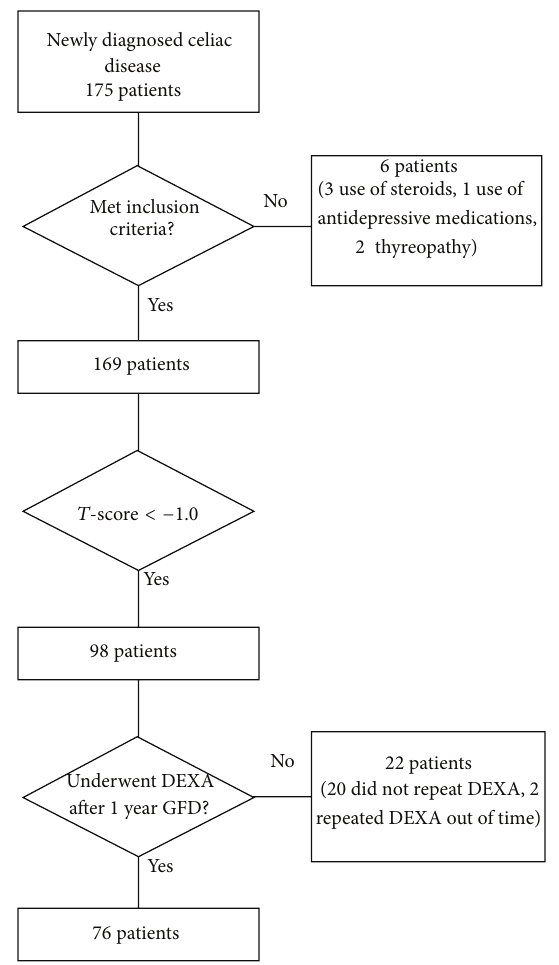
Figure 1: Patients included in the